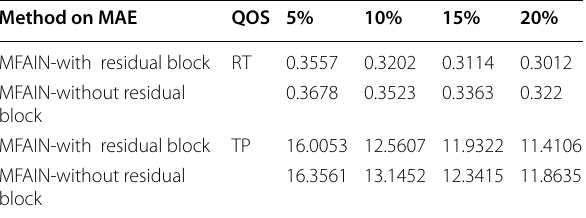
Table 6 Impact of the Residual